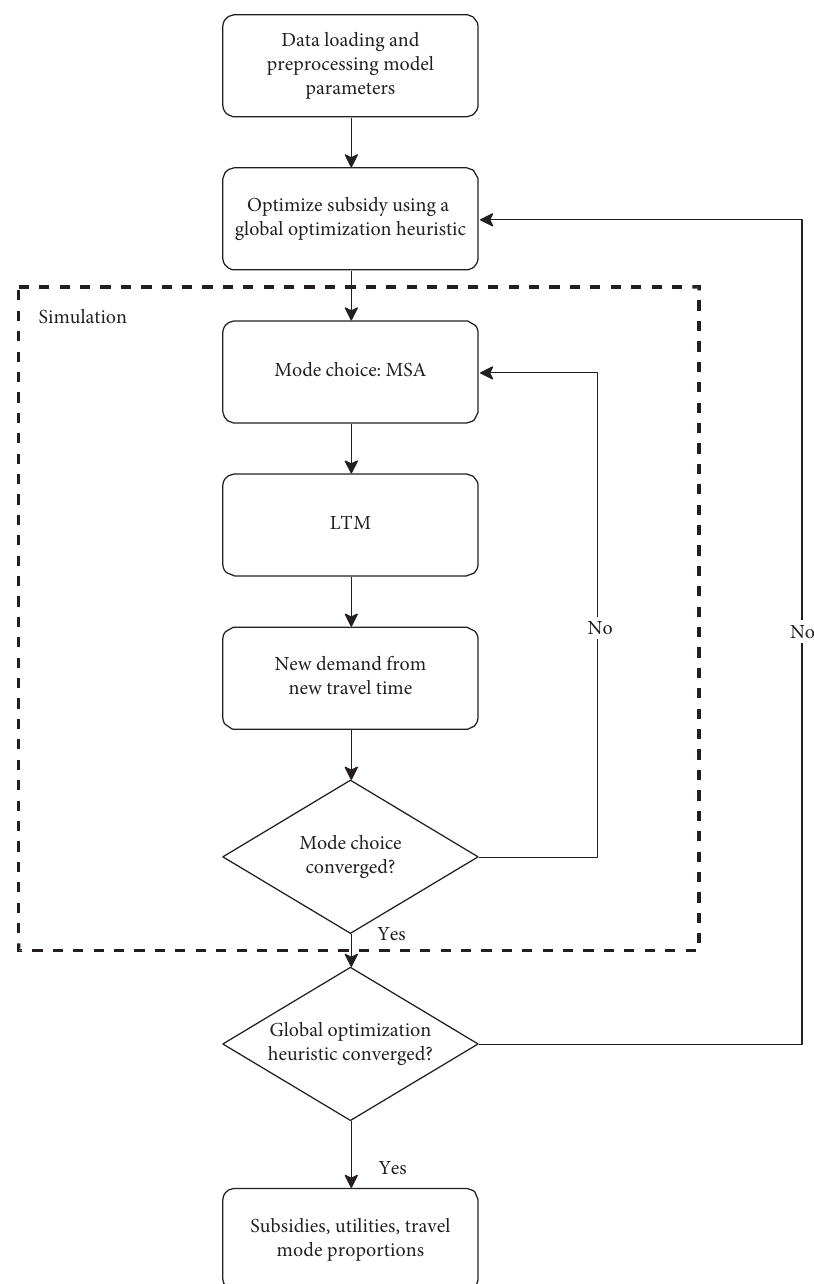
Figure 1: Flowchart of the simulation-based optimization framework. The procedure simulation ( y ) is shown with a dashed